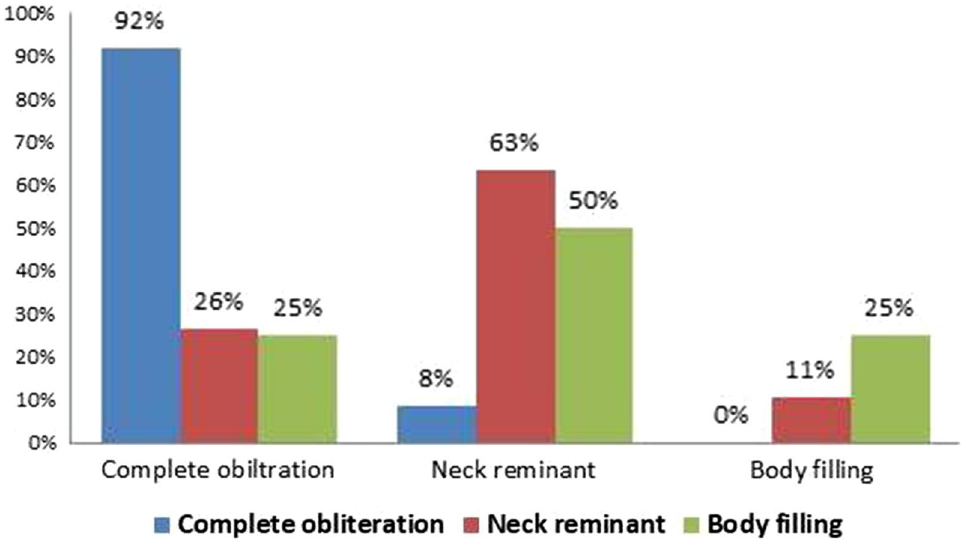
Fig. 4 Aneurysm stability at 1-year follow-up in relation to the initial control